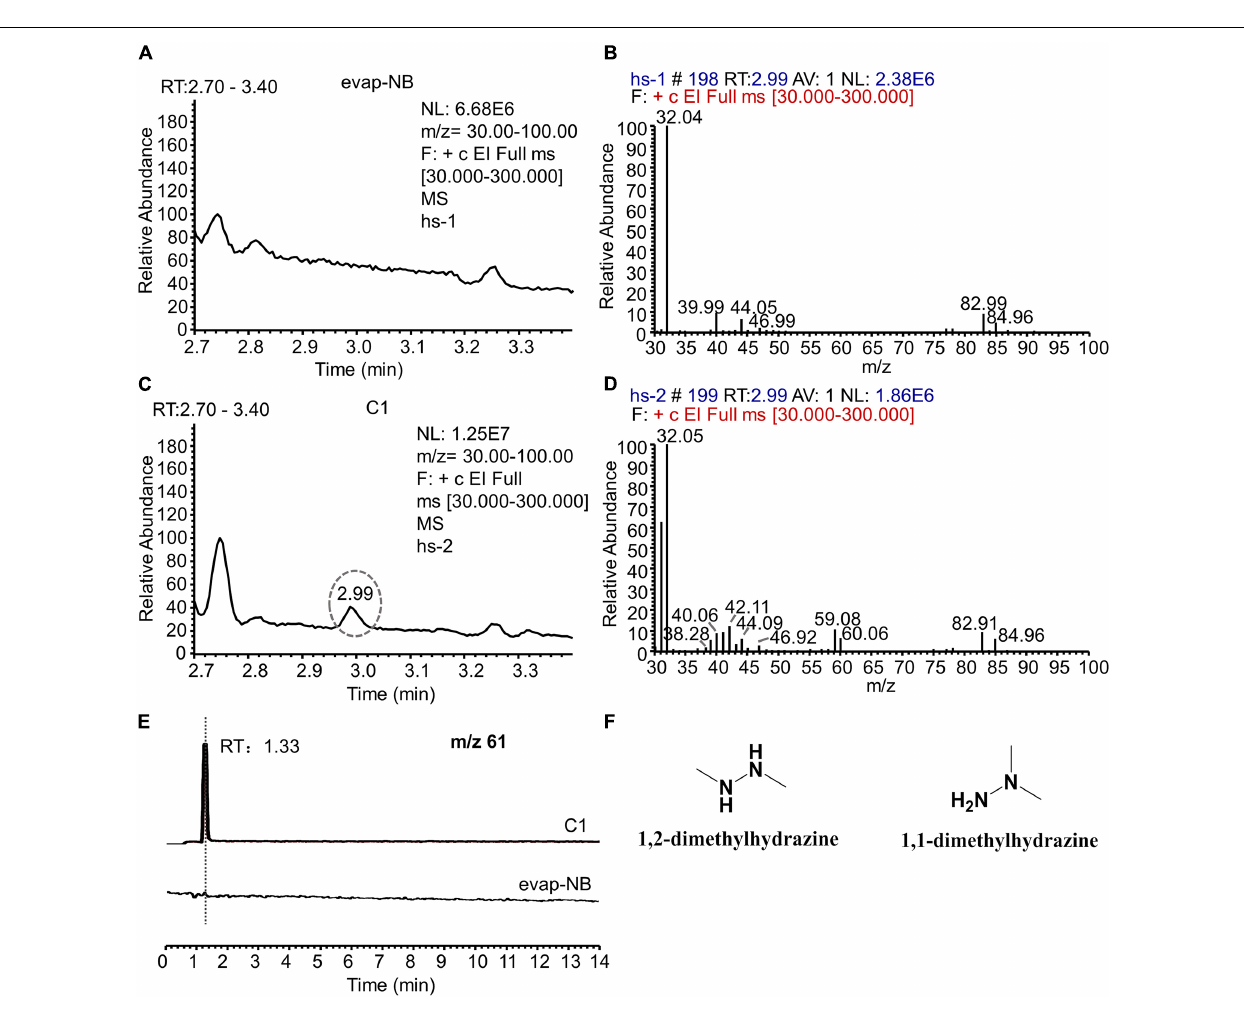
Frontiers in Microbiology |